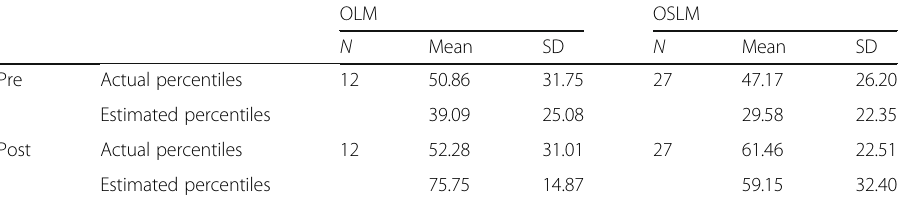
Table 10 The students ’ actual percentiles and their estimated percentiles for the OLM and OSLM groups